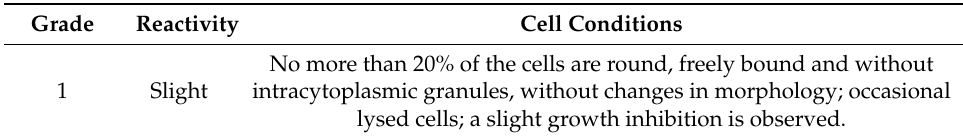
Table 4. Morphological conditions of cell